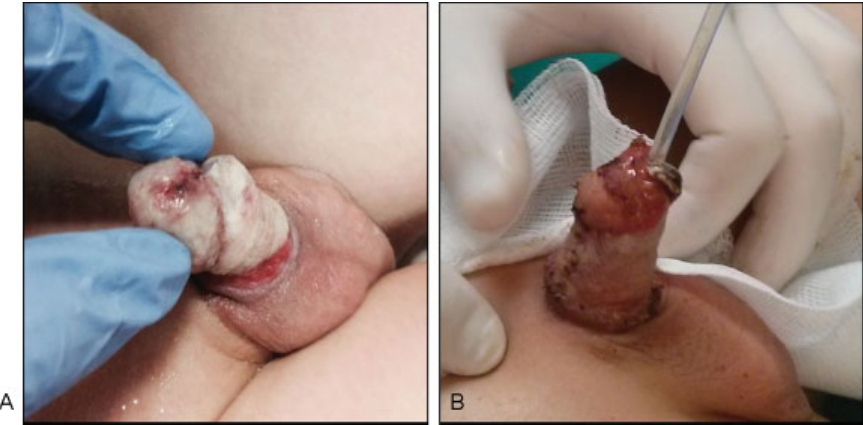
Fig. 1 ( A ) Lack of penile skin after ritual circumcision. ( B ) Reconstruction with FTSG 1 month after circumcision, at 4 years of age. FTSG, full- thickness skin